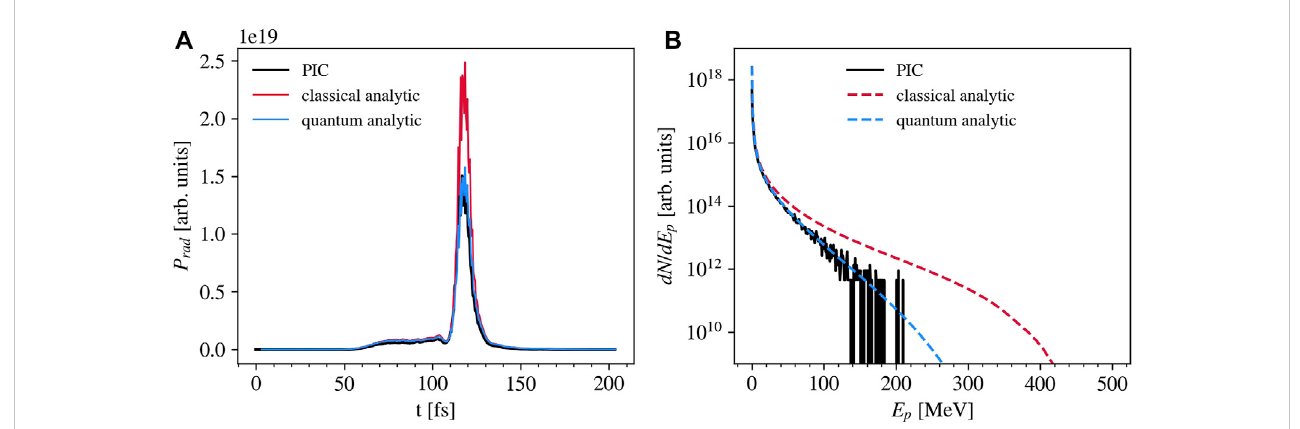
FIGURE 4 Comparison among emission properties obtained in simulation A and estimated analytically considering synchrotron emission classically or including quantum effects. Plot (A) shows the evolution in time of the emitted power densities. Plot (B) shows the fi nal photon